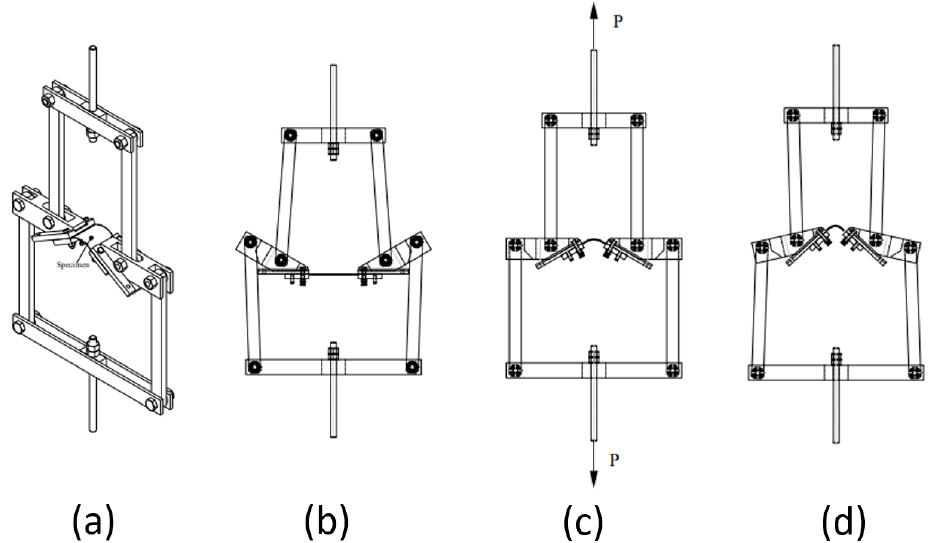
Figure 2. ( a ) clamping system for bending test. Different clamping configurations ( b ) Starting position; ( c ) Pure applied bending moment corresponding to 30°; ( d ) generic position [22].